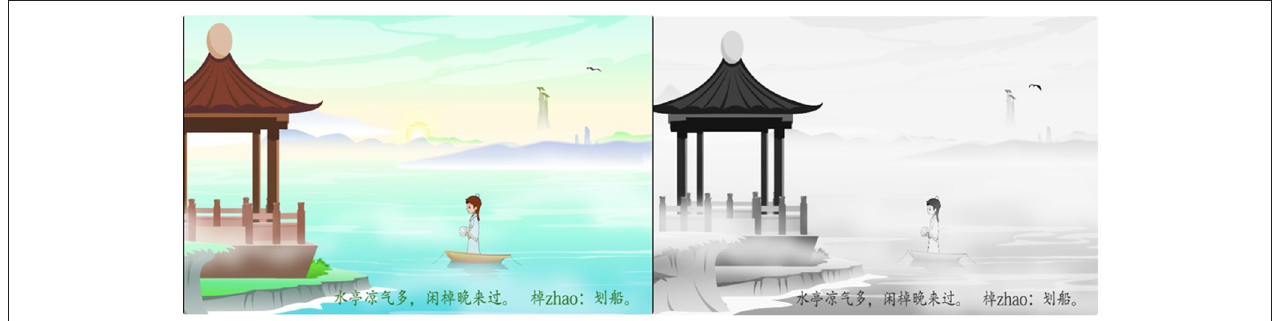
FIGURE 1 | Screenshots of multimedia learning materials in the preliminary experiment: internal colorful design (IC) on the left and internal neutral design (IN) on the